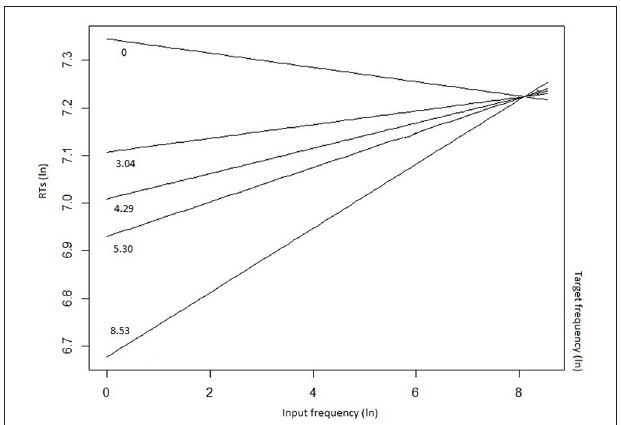
FIGURE 3 | Input frequency by target frequency interaction on reaction times